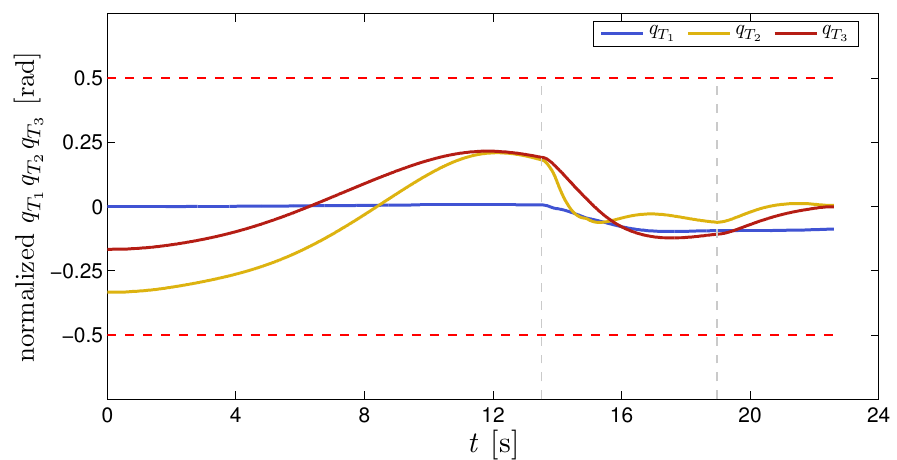
Figure 12. Changes of the configuration variables for the torso.